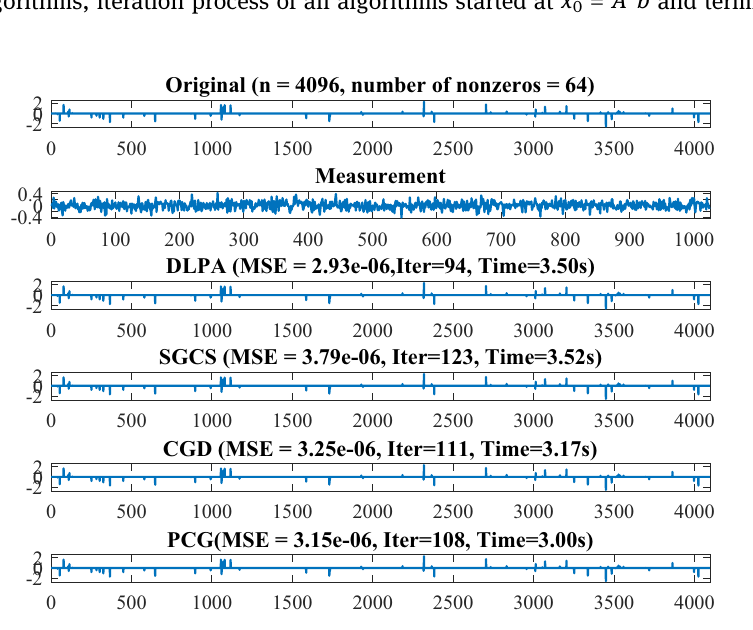
Figure 4: Reconstruction of sparse signal. From the top to the bottom is the original signal ( fi rst plot ) , the measurement ( second plot ) , and the reconstructed signals by DLPA ( third plot ) , SGCS ( Fourth plot ) , CGD ( fi fth plot ) , and PCG ( sixth plot )